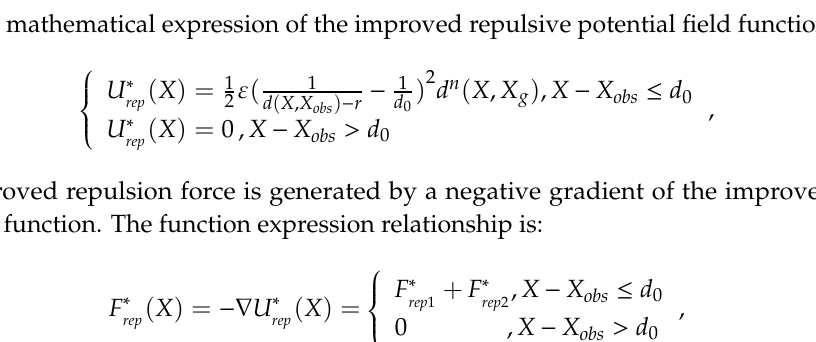
Figure 7. Schematic diagram of obstacle distance.